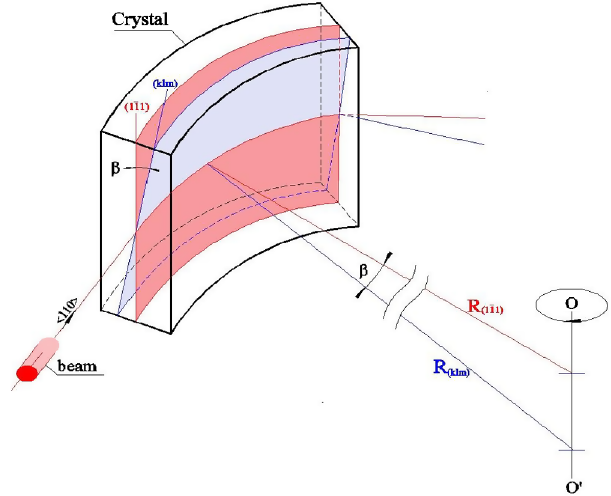
FIG. 9. Beam deflection by the ð klm Þ